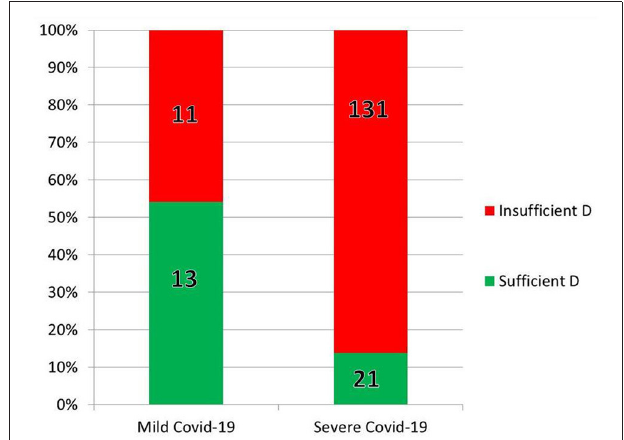
FIGURE 8 | Some of the results of the retrospective chart review by Glicio et al. (5). In the 176 elderly (over age 60) hospitalized individuals tested for both 25(OH)D and COVID-19, vitamin D predicted severity of